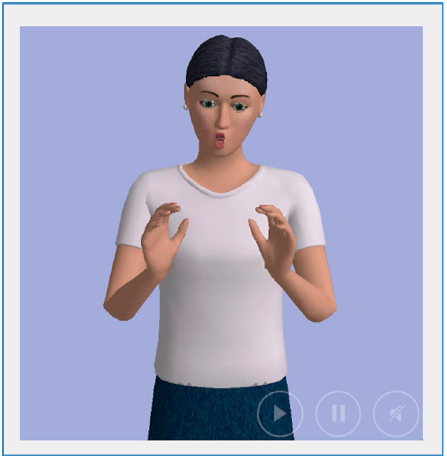
Figure 3. Non-manual parameters of user acceptance regarding synthetic signing naturalness.